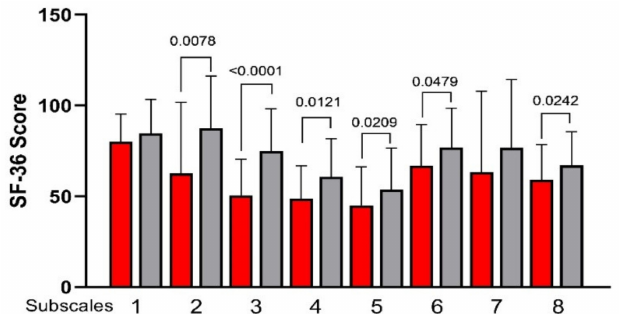
Figure 3. The 36-Item Short-Form Health Survey (SF-36) subscale scores before and after low FODMAPs diet. Data are presented as mean ± SD. Statistical analysis: Wilcoxon matched-pairs signed-rank test with a significant difference set at p < 0.05. Subscales: (1) Physical Function; (2) Role Physical; (3) Body Pain; (4) General Health; (5) Vitality; (6) Social Functioning; (7) Role Emotional; (8) Mental